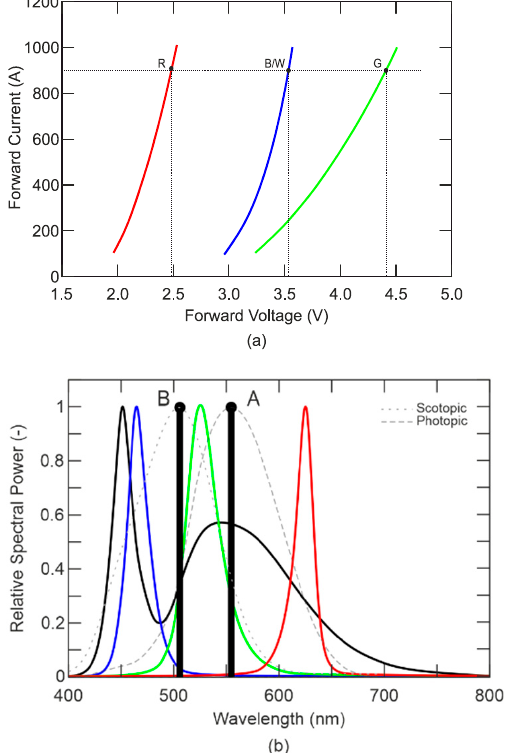
Figure 3. ( a ) RGB current-voltage characteristics; ( b ) typical relative spectral power vs. wavelength (adapted from [21]).